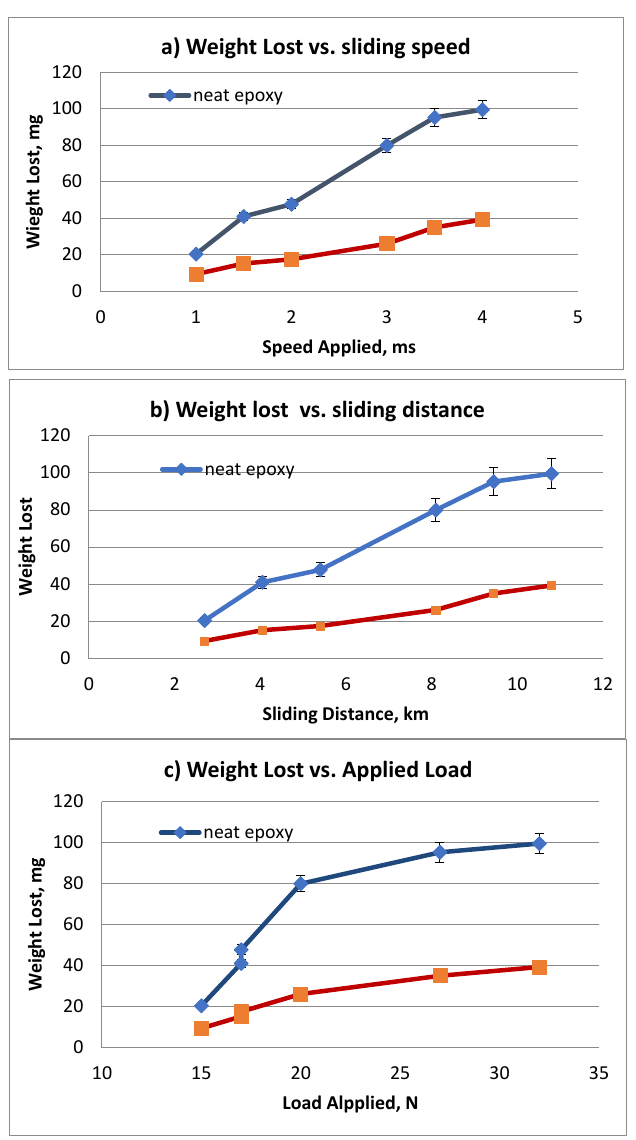
Figure 6. Relationship between weight lost and sliding distance, sliding speed and applied load.